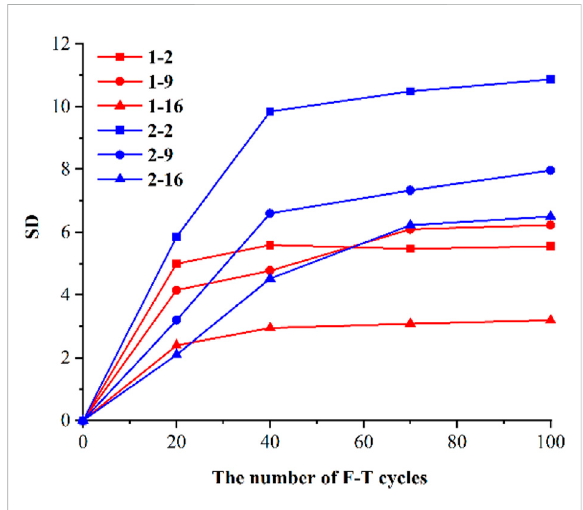
FIGURE 8 SD values for different scanning layers of granite under different numbers of F – T cycles.